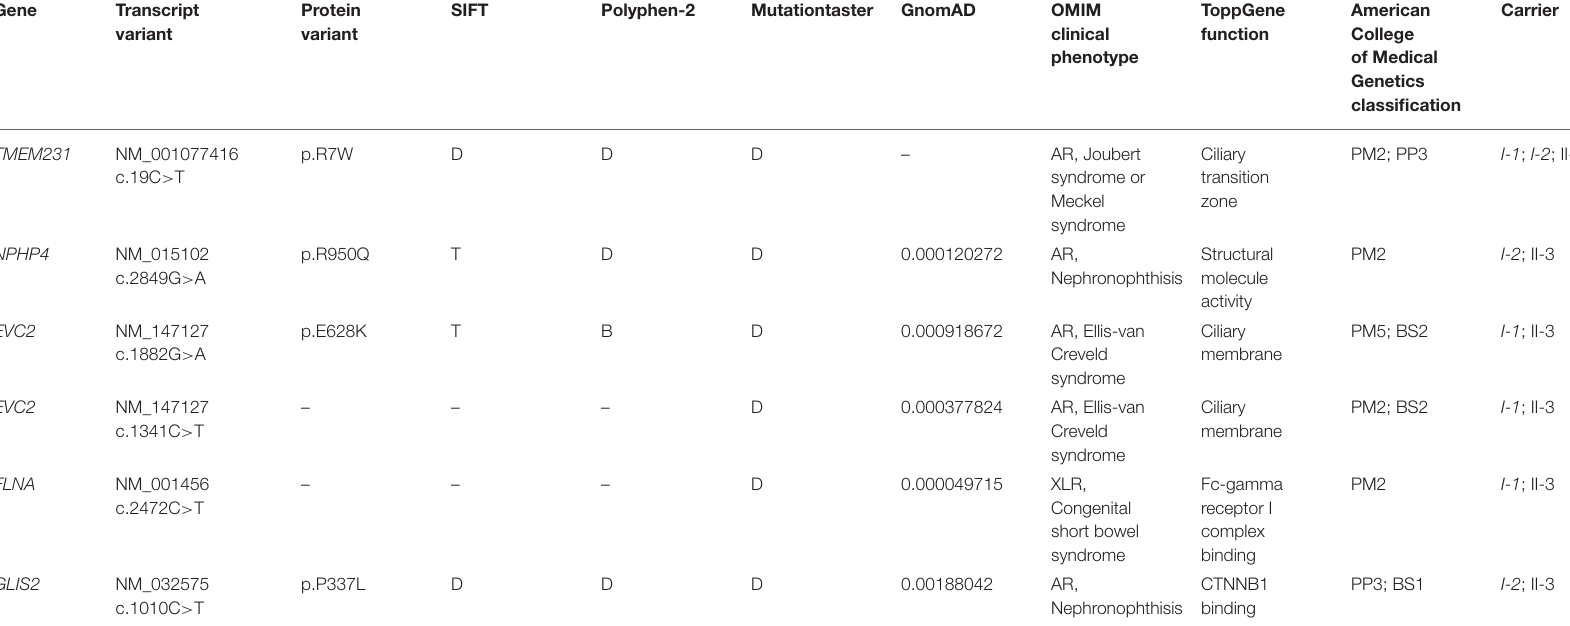
TABLE 2 | Variants identified by WES in this